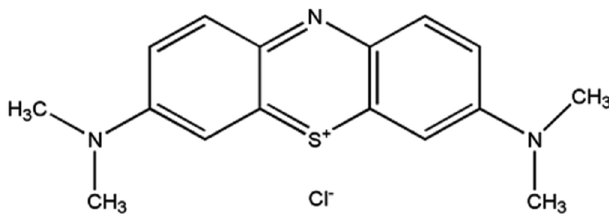
Figure 12. The molecular structure for methylene blue.